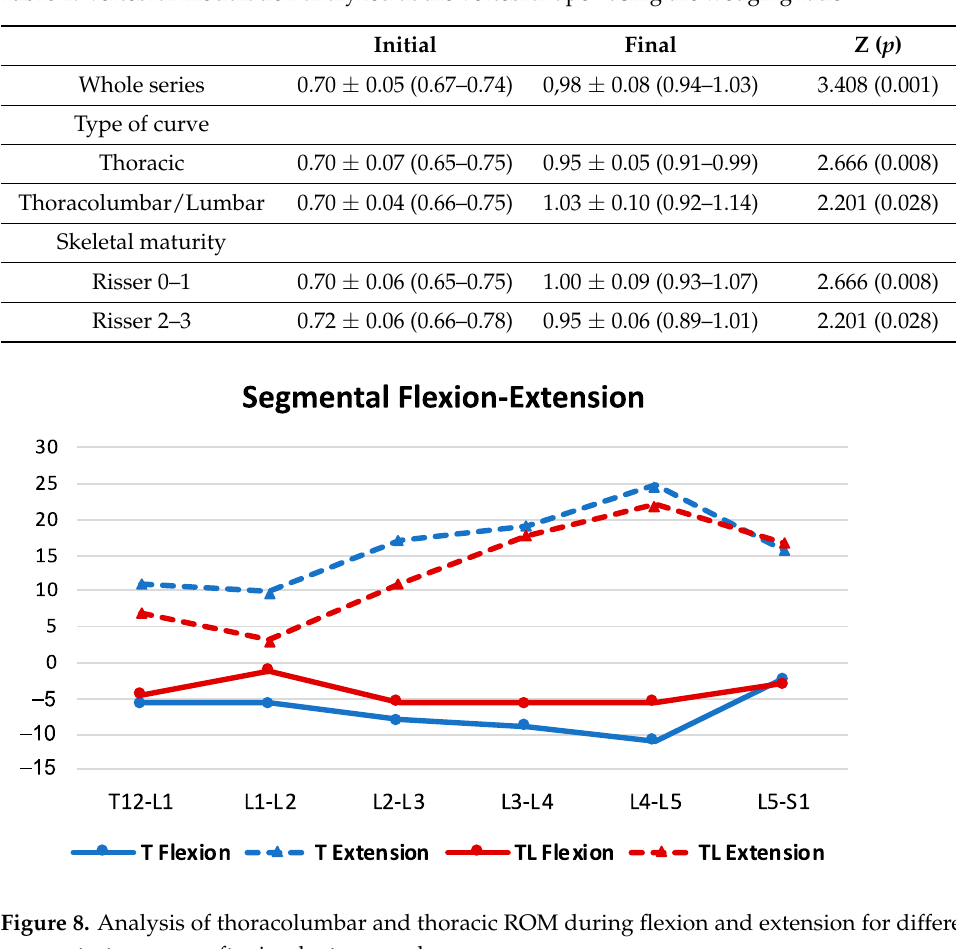
Figure 8. Analysis of thoracolumbar and thoracic ROM during flexion and extension for different segments, two years after implant removal.